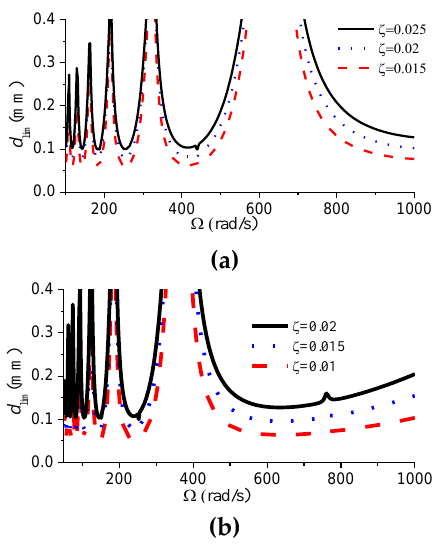
Figure 11. The influence of viscous damping on stable zone for ( a ) composite milling bar and ( b ) steel milling bar.